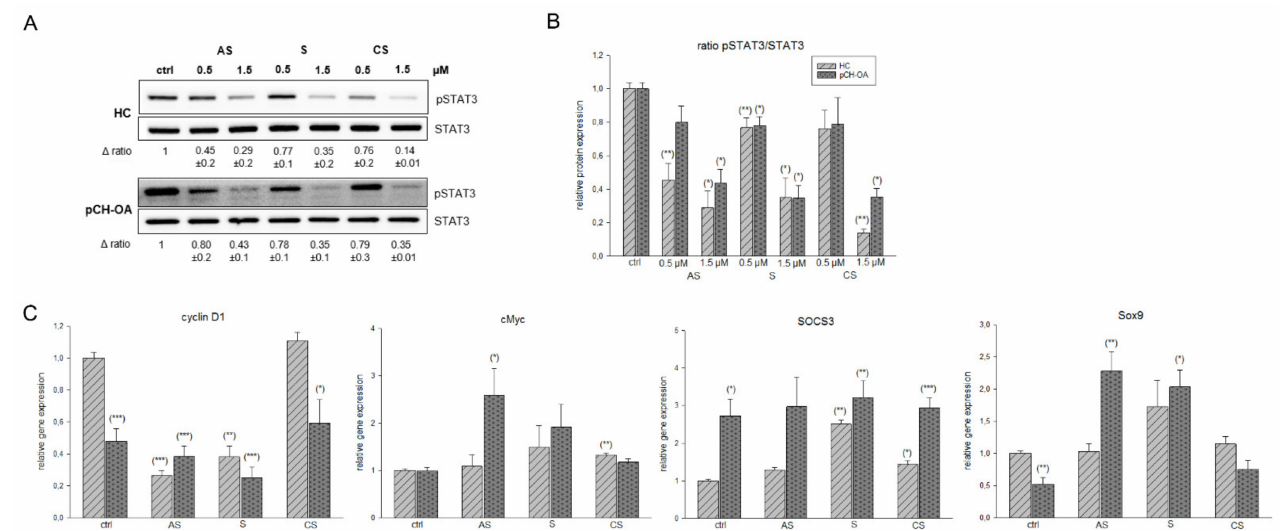
Figure 5. Inhibition of STAT3 phosphorylation and the influence of shikonin derivatives on STAT3 downstream targets. ( A ) The STAT3 protein phosphorylation was evaluated by immunoblotting under untreated control conditions (ctrl) and in the presence of 0.5 µ M and 1.5 µ M acetylshikonin (AS), shikonin (S), and cyclopropylshikonin (CS) for 1 h in HC and IL-1 β -stimulated pCH-OA cells. STAT3 were used as loading controls. ∆ , fold change normalized to controls (mean ± SD, n = 3). ( B ) shows the densiometric evaluation of all experiments in HC (light grey striped) and pCH-OA (dark grey dotted) cells. ( C ) Relative gene expression of the downstream targets cyclin D1, cMyc, SOCS3, and Sox9 after treatment with shikonin derivatives for 24 h (mean ± SD, n = 6, measured in triplicates). Statistical significances are defined as follows: * p < 0.05; ** p < 0.01; *** p <